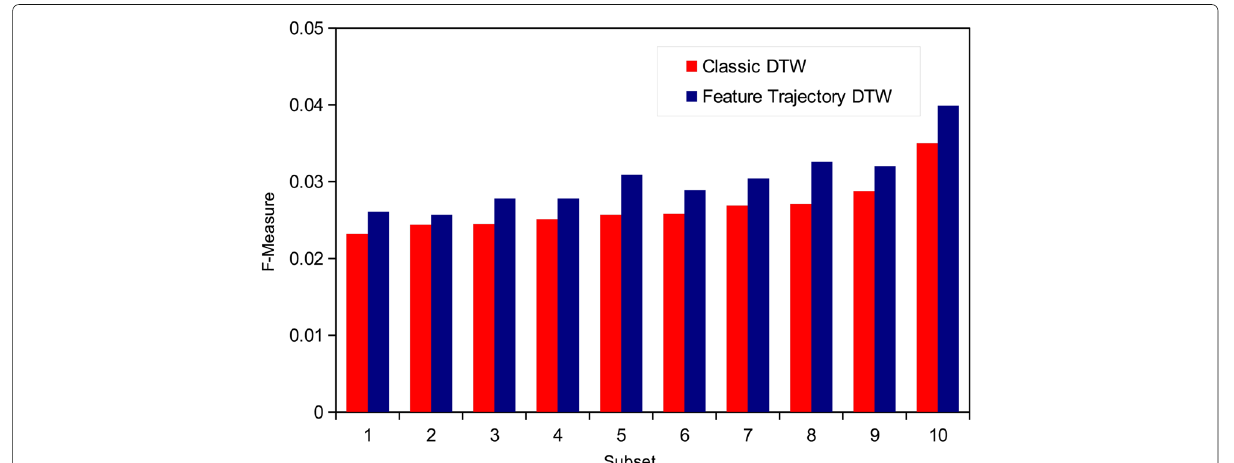
Fig. 6 Clustering performance for the 10 independent subsets of dataset 3 in terms of